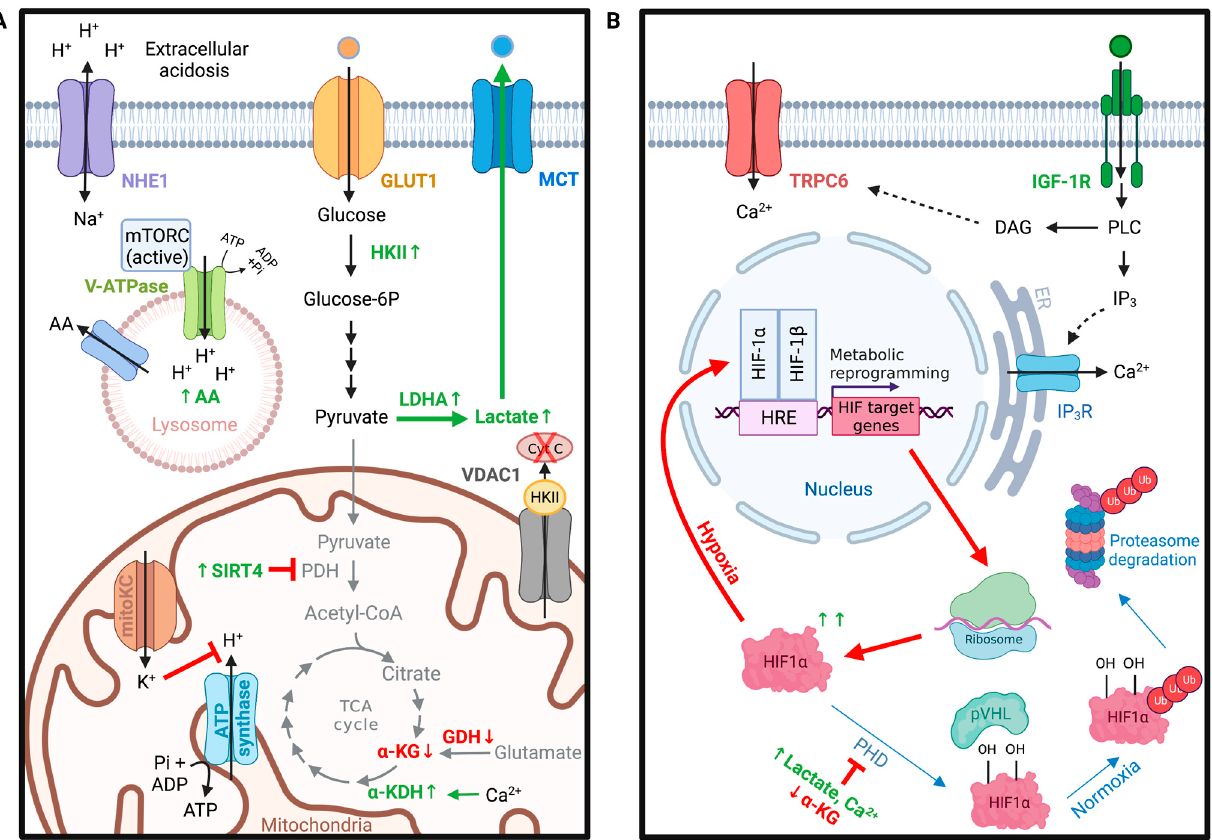
Figure 3. Ion channels in glioma metabolism. ( A ) Ion channels involved in glioma metabolic shift toward aerobic glycolysis over mitochondrial oxidative phosphorylation (Warburg effect). ( B ) TRPC6 channels control the stability of HIF1 α in gliomas under hypoxia resulting in the upregulation of genes involved in glioma’s metabolic reprogramming. Abbreviations: α -KDH = α -ketodehydrogenase, α -KG = α -ketoglutarate, AA = amino acid, Cyt C = cytochrome c, GDH = glutamate dehydrogenase, GLUT1 = glucose transporter protein type 1, HKII = hexokinase II, Kv1.3 = voltage- gated potassium channel, LDHA = lactate dehydrogenase A, MCT = monocarboxylate transporter, mitoKC = mitochondria K + channels, mTORC = mammalian target of rapamycin, NHE1 = Na-H exchanger 1, PDH = pyruvate dehydrogenase, SIRT4 = sirtuin 4, TCA cycle = tricarboxylic acid cycle, V-ATPase = vacuolar-type ATPase, VDAC1 = voltage-dependent anion channel 1. DAG = diacyl glycerol, ER = endoplasmic reticulum, HIF1 α = hypoxia-inducible factor 1 α , HRE = hypoxia-re- sponse elements, IGF-1R = insulin-like growth factor 1 receptor, IP 3 = inositol 1,4,5-triphosphate, IP 3 R = inositol 1,4,5-triphosphate receptor, PHD = prolyl hydroxylases, PLC = phospholipase C, pVHL = von Hippel-Lindau tumor suppressor, TRPC6 = transient receptor potential cation channel subfamily C member 6. Created with BioRender.com.